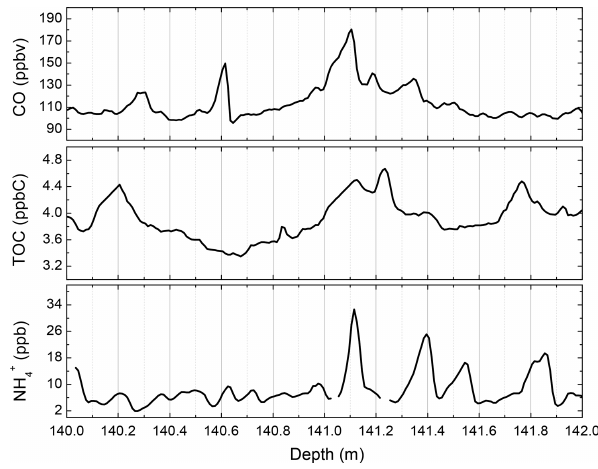
Figure 5. Running averages (10m windows) of TOC and CO con- centrations for the Tunu13 core, plotted along with the annually av- + , and CO from the Tunu13 Figure 4. High-resolution TOC, NH eraged surface snow accumulation 4 core. Snow accumulation is about 8cmw . e . yr − 1 at this depth.